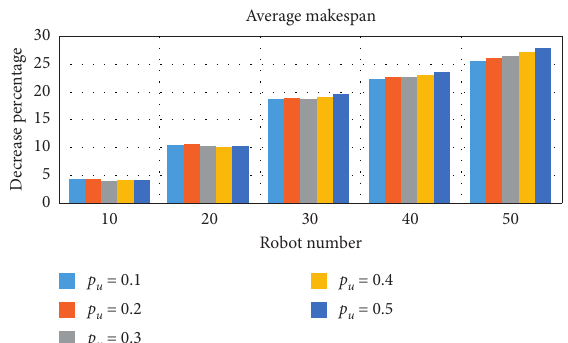
Figure 8: Decrease percentage of average makespan in a warehouse environment of 50 × 34 4-neighbor grids.